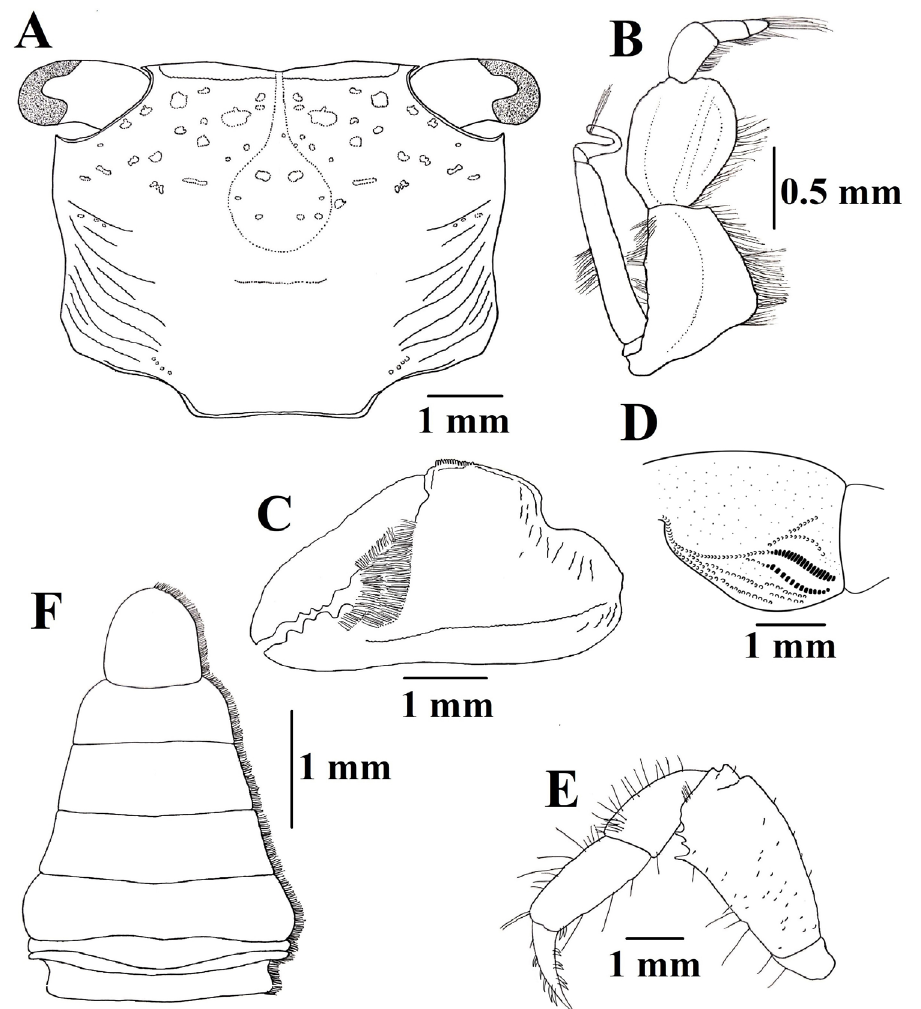
Figure 3. Nanosesarma batavicum (Moreira, 1903). Male, (GUMSIS1) (CL: 4.8 mm; CW: 6.6 mm), Verem, Goa, India. ( A ) Carapace; ( B ) right third maxilliped; ( C ) palm of left cheliped (outer face); ( D ) dorsal view of left cheliped palm; ( E ) left P5 (dorsal view); ( F ) male pleon.